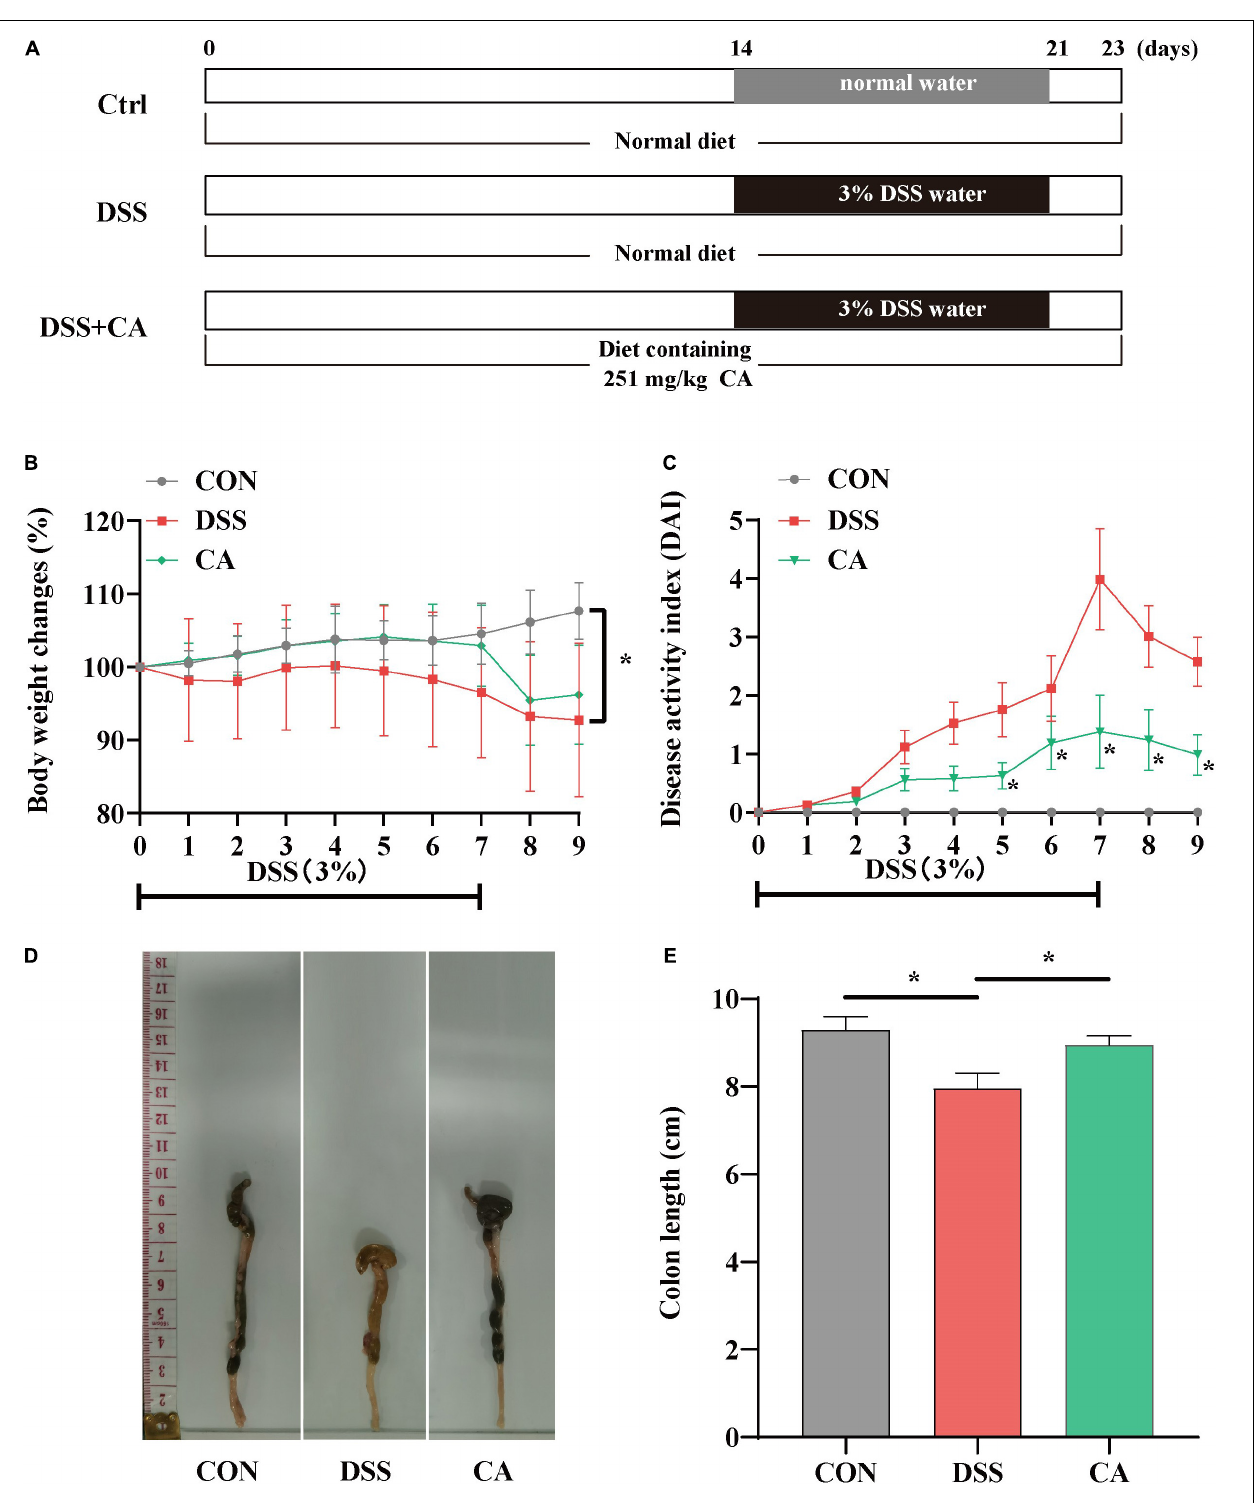
FIGURE 1 | Experimental schedule and basic indicators of caffeic acid (CA) on DSS-induced colitis mice. (A) Animal treatments schedule. (B) Body weight changes. (C) Disease activity index (DAI) score during experimental colitis. (D) Images of the colon length. (E) The colon length in the different treatment groups. Data are presented as means ± SEM ( n = 16 per group). * p < 0.05 vs. the DSS-treated group on the same day. CON, control group; DSS, DSS group; CA, caffeic acid group. The same as below.